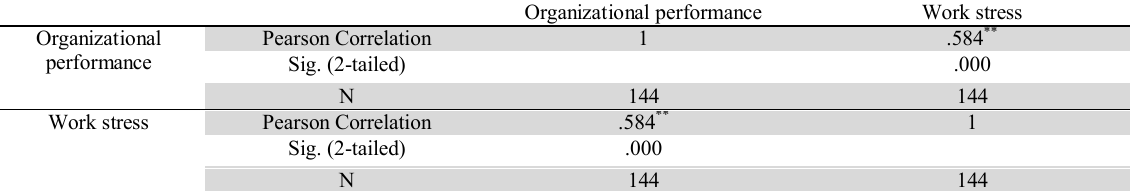
Organizational performance